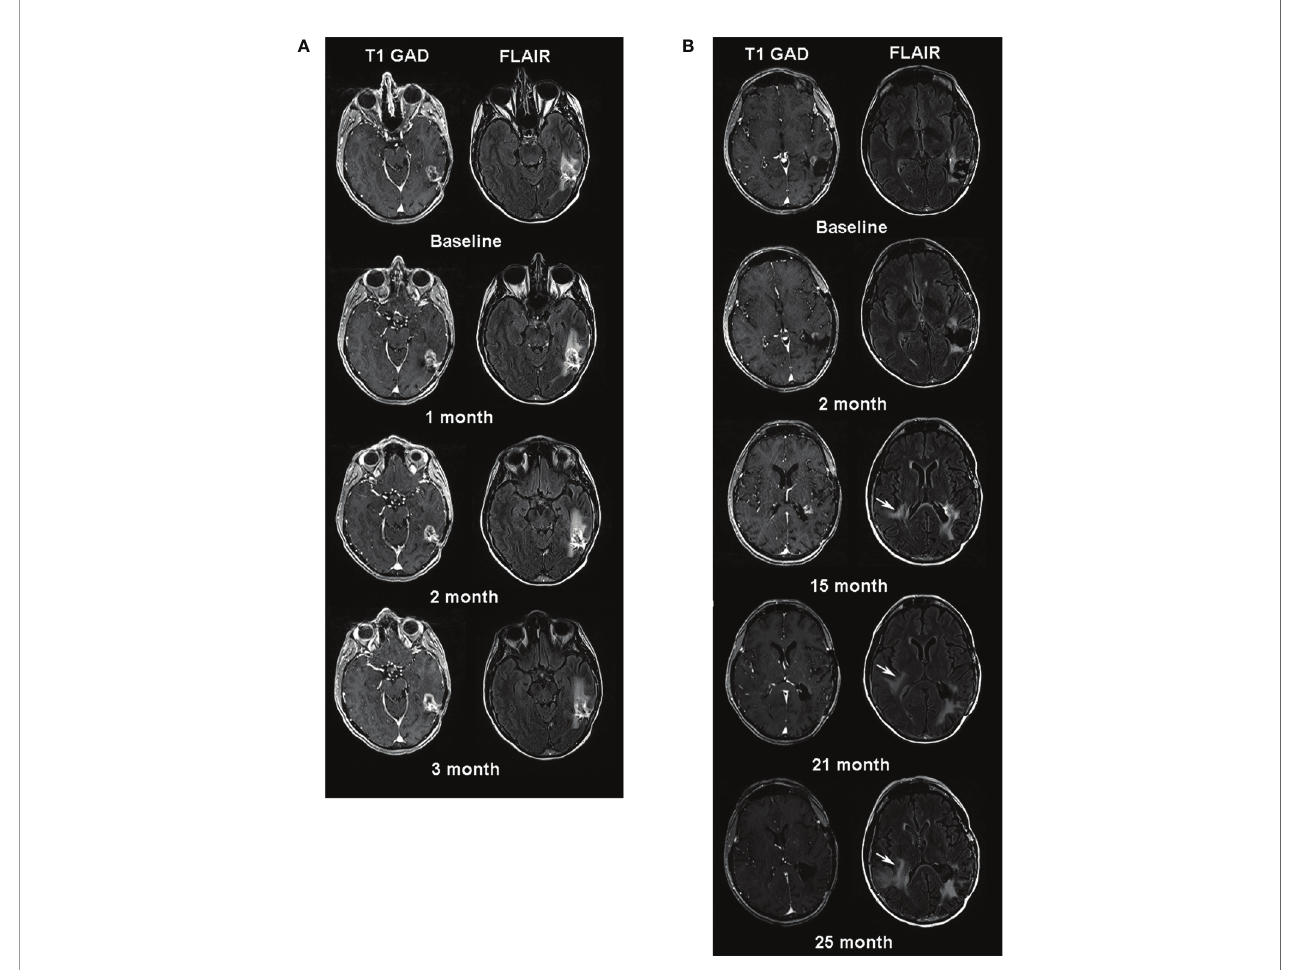
FIGURE 1 | (A) Serial MR images one week before (baseline) and three months after CAR T-EGFRvIII infusion. Left sided images are axial post contrast T1 weighted images and right sided images are axial FLAIR images. Note, minimal increase in size of the enhancing lesion in the left temporal lobe at follow-up time-points. (B) Serial MRI examinations after the patient ’ s second surgery. The baseline is one month after her second surgery. White arrows at 15, 21- and 25-month follow-up periods indicate the increasing signal abnormality in the right periventricular region on FLAIR